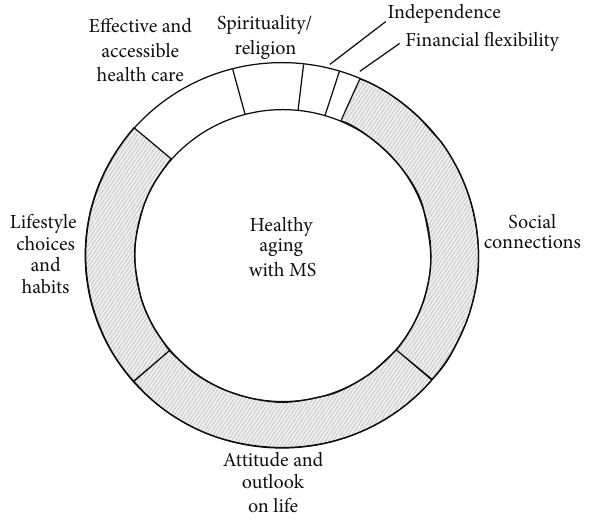
Figure 4: Healthy aging with MS. Healthy aging with MS is encircled by the seven contributing factors, illustrating the multi- dimensionality and interdependent nature of the connections. The model is comprised of two levels of factors: primary factors which are most important to older people with MS, which include social connections, attitude and outlook on life, and lifestyle choices and habits andsecondary factorswhich arelessprominently displayed in the model illustrating their relative importance and include effective and accessible health care, spirituality and religion, independence, and financial